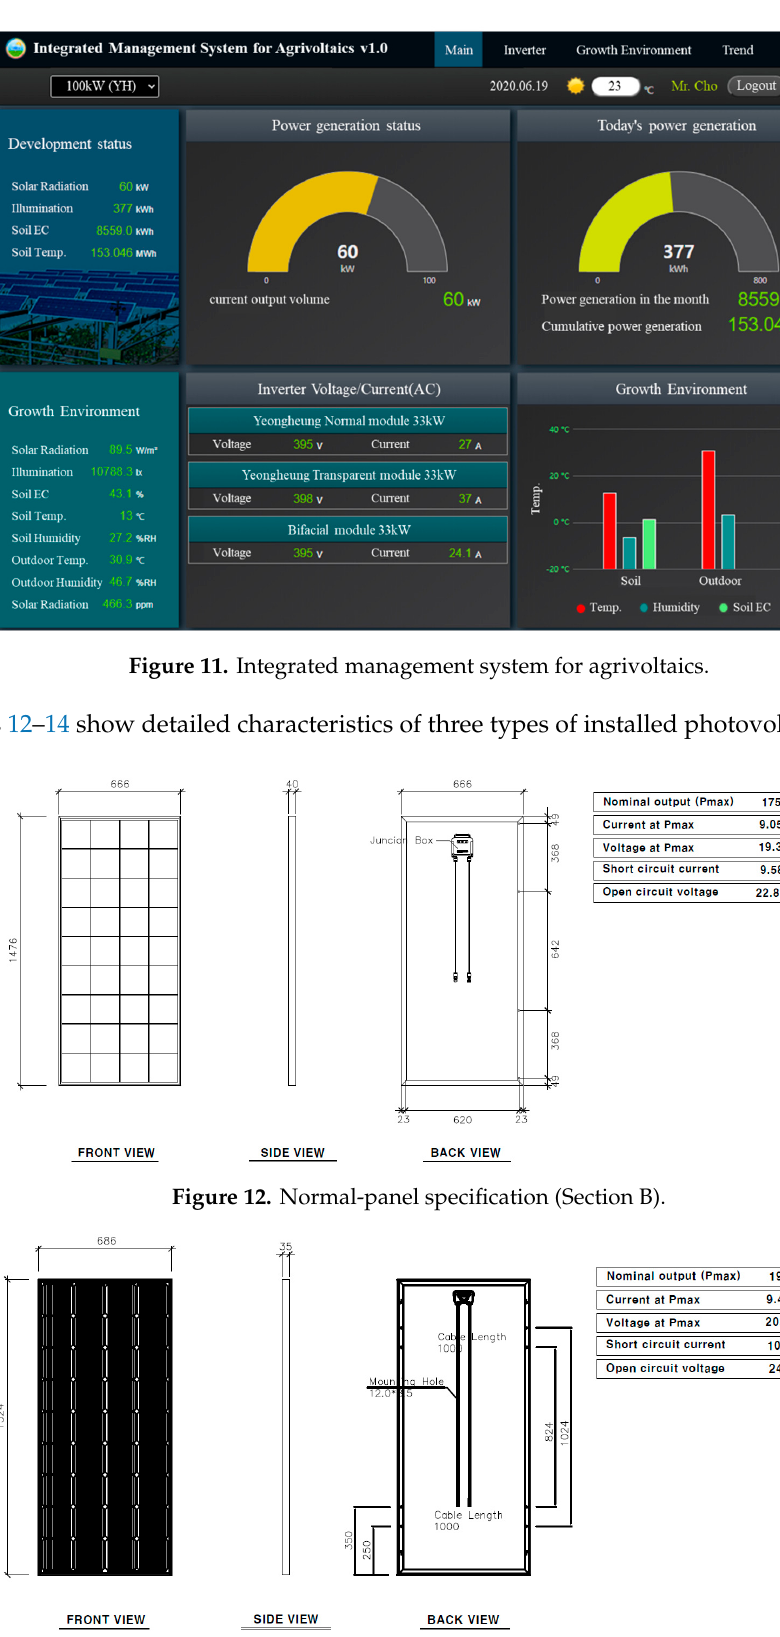
Figure 10. Smart-farming-system diagram.